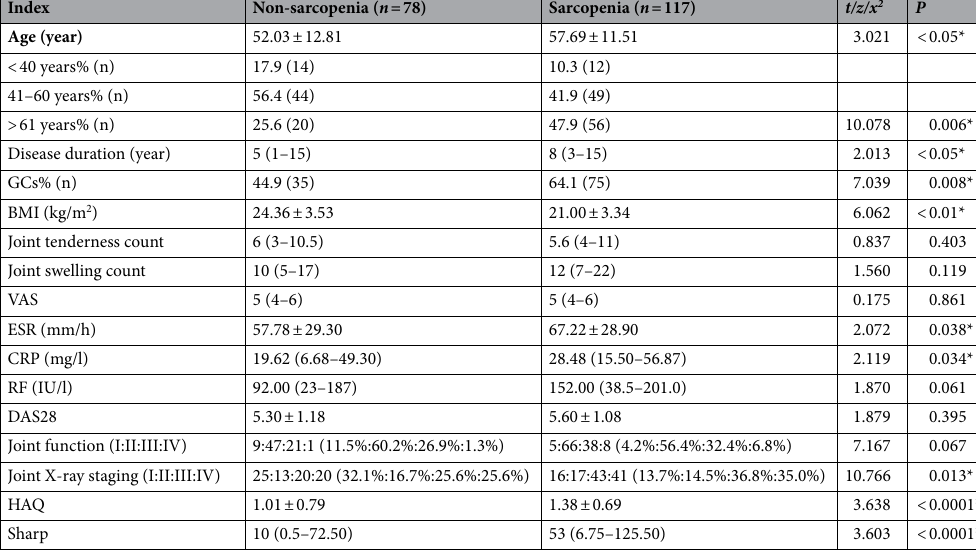
Table 2. Comparison of disease-related indexes between RA with sarcopenia or not. Mean and standard deviation for the continuous variables and number of participants (n) and percentages (%) for the categorical variables. * P value < 0.05.